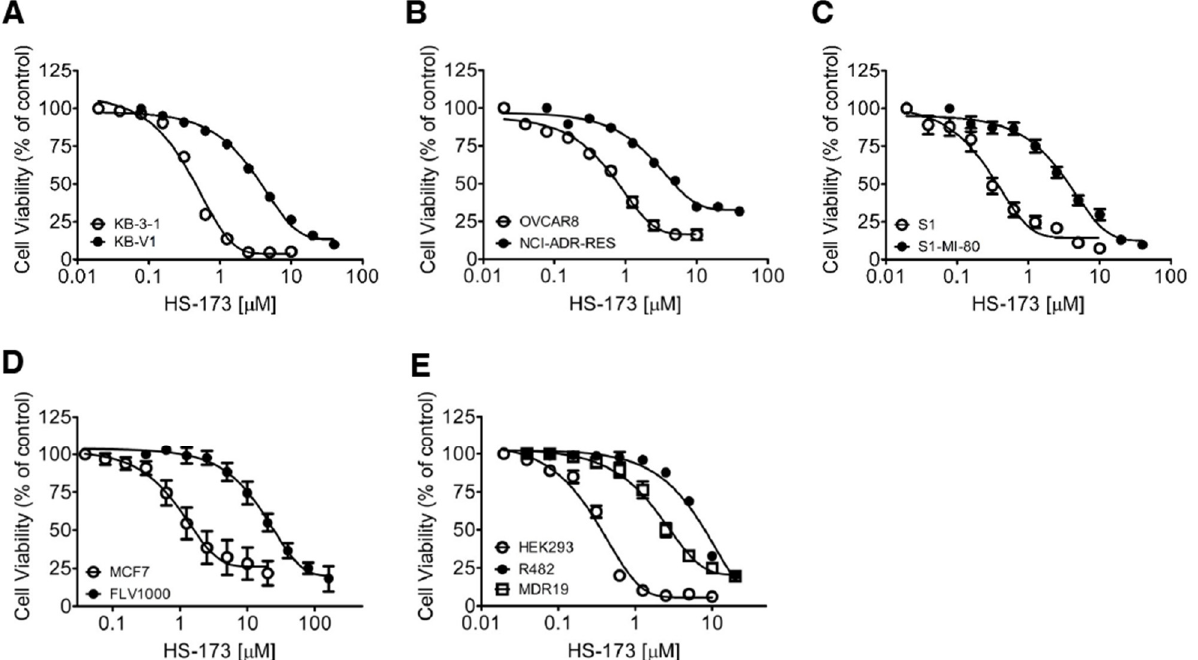
Figure 1. Dose–response curves for parental and multidrug-resistant cell lines overexpressing ABCB1 or ABCG2 treated with HS-173. The cytotoxicity of HS-173 in ( A ) the parental human KB-3-1 epidermal cancer cell line (open circles) and its ABCB1-overexpressing multidrug-resistant subline KB-V1 (filled circles); ( B ) parental human OVCAR-8 ovarian cancer cell line (open circles) and its ABCB1-overexpressing multidrug-resistant subline NCI-ADR-RES (filled circles); ( C ) parental human S1 colon cancer cell line (open circles) and its ABCG2-overexpressing multidrug-resistant subline